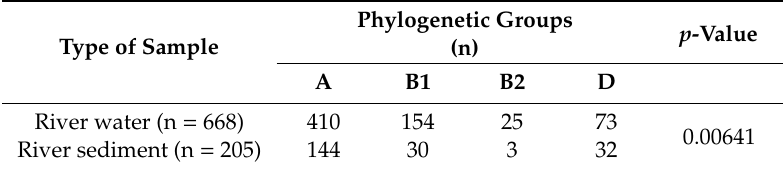
Table 4. Phylogenetic grouping of resistant E. coli isolated from water and sediment samples of the Kshipra river in India.